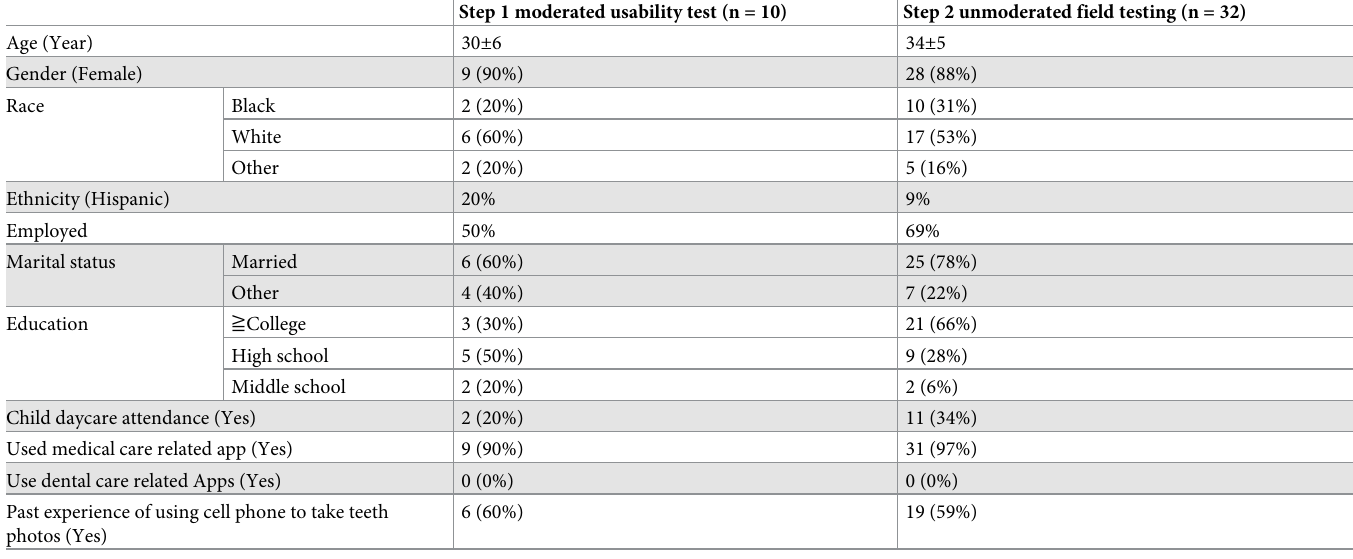
Table 1. Demographic-socioeconomic-behavior information of